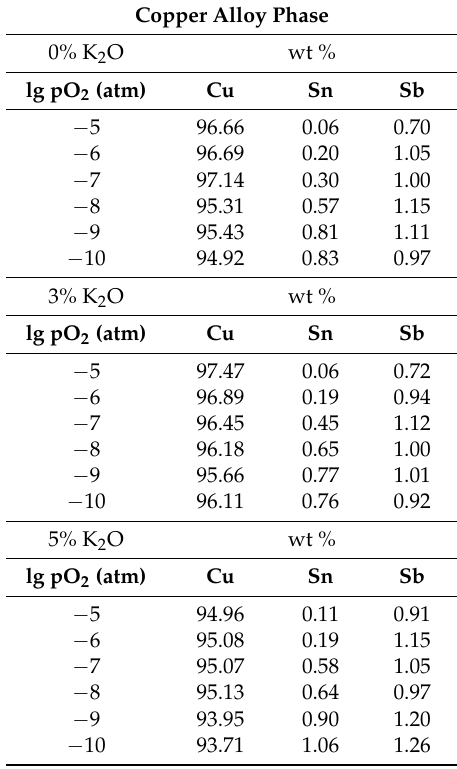
Table A2. Concentrations of copper, tin and antimony in copper alloy phase. All results are from EPMA, in wt